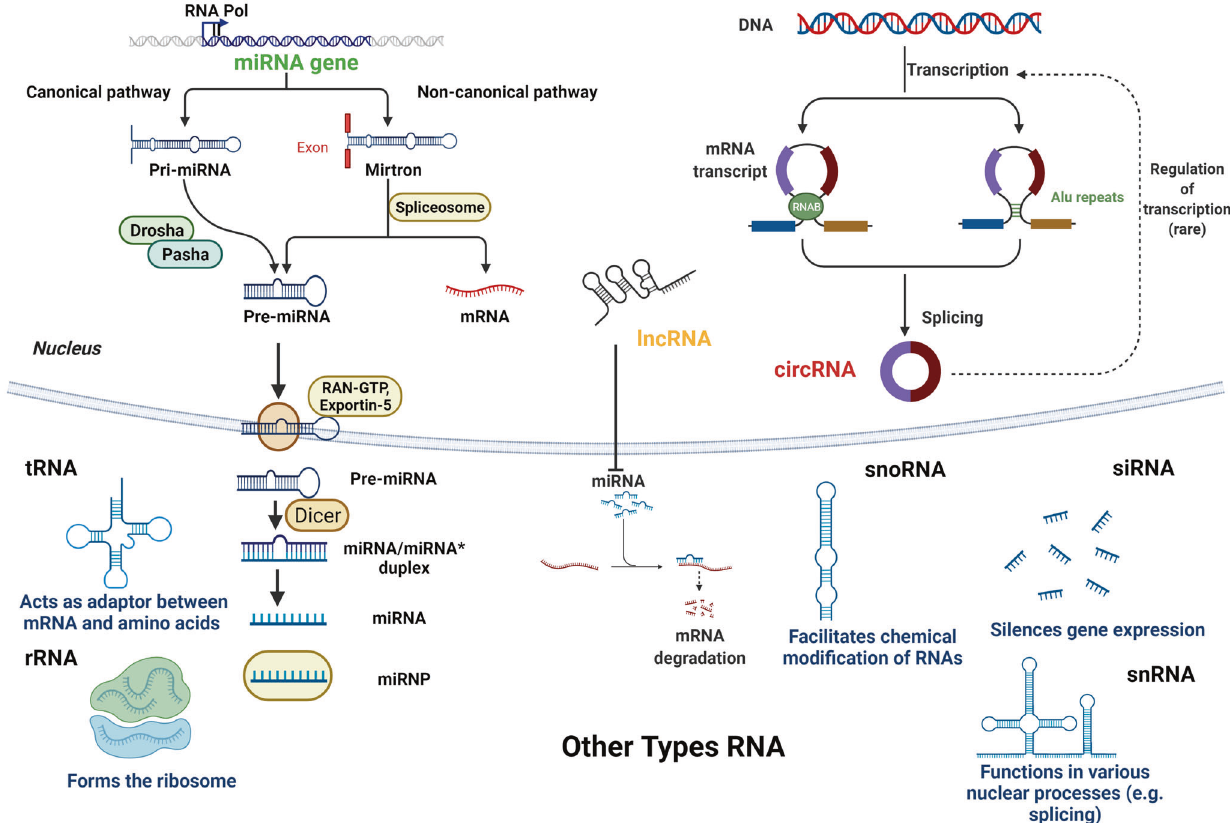
Fig. 3 Noncoding RNA regulation. Different mechanisms of action of noncoding RNAs in epigenetic regulations. (1) <50 nt: MicroRNAs (miRNAs): miRNAs complement mRNAs and promote mRNA silencing or degradation. Small interfering RNAs(siRNA): silences gene expression. (2) 50 – 500 nt: nucleolar small RNA(snoRNA): snoRNA biological function was initially found to modify rRNA. Nuclear small RNA(snRNA): snRNA function is to combine with protein factors to form small nuclear ribonucleoprotein particle and perform the function of splicing